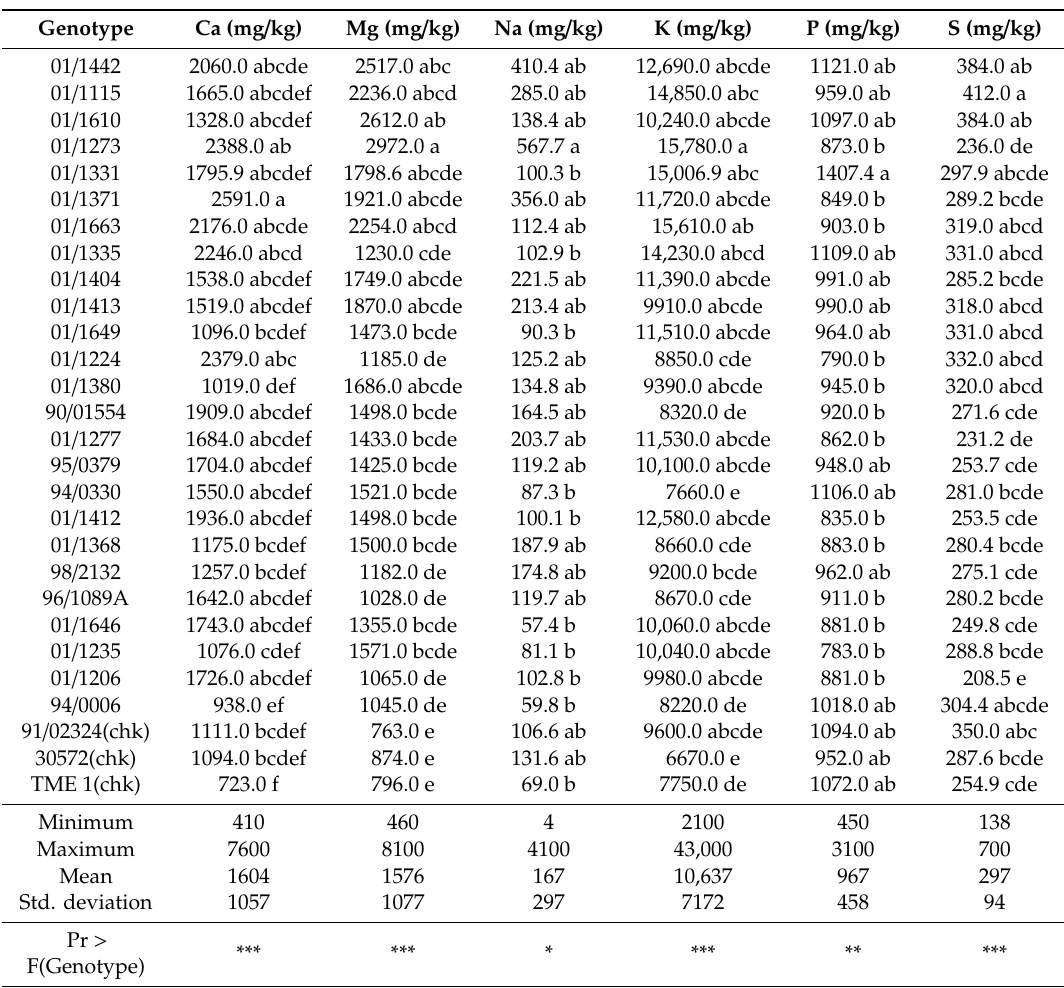
Table 4. Mean value of macro elements of yellow-fleshed cassava roots by genotypes and across